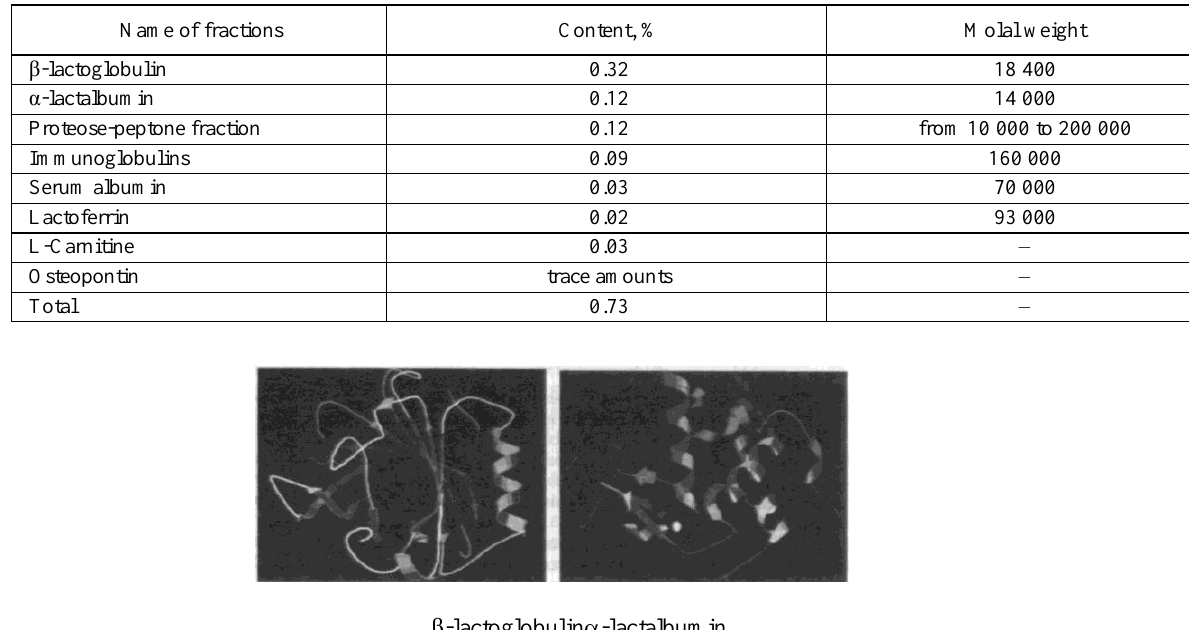
Fig. 5. Molecular structures of some whey